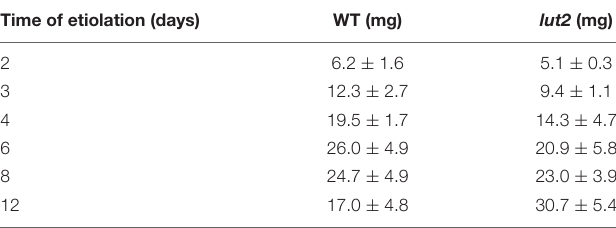
TABLE 1 | The fresh weight (FW) of seedlings normalized to 1 mg of seeds that were used for the culture. Time of etiolation